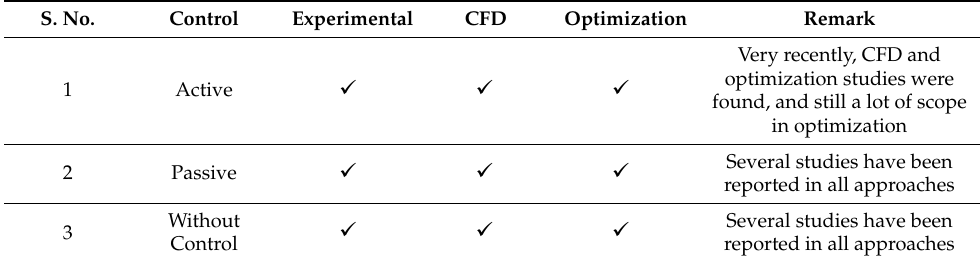
Table 1. Major observation for active flow control.